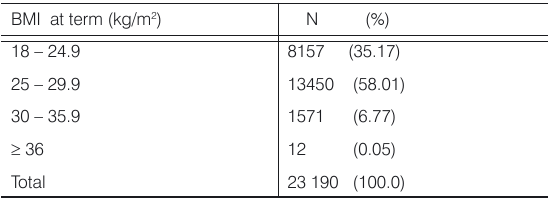
Table 1. Stratification of women according to term BMI (N = 23190).